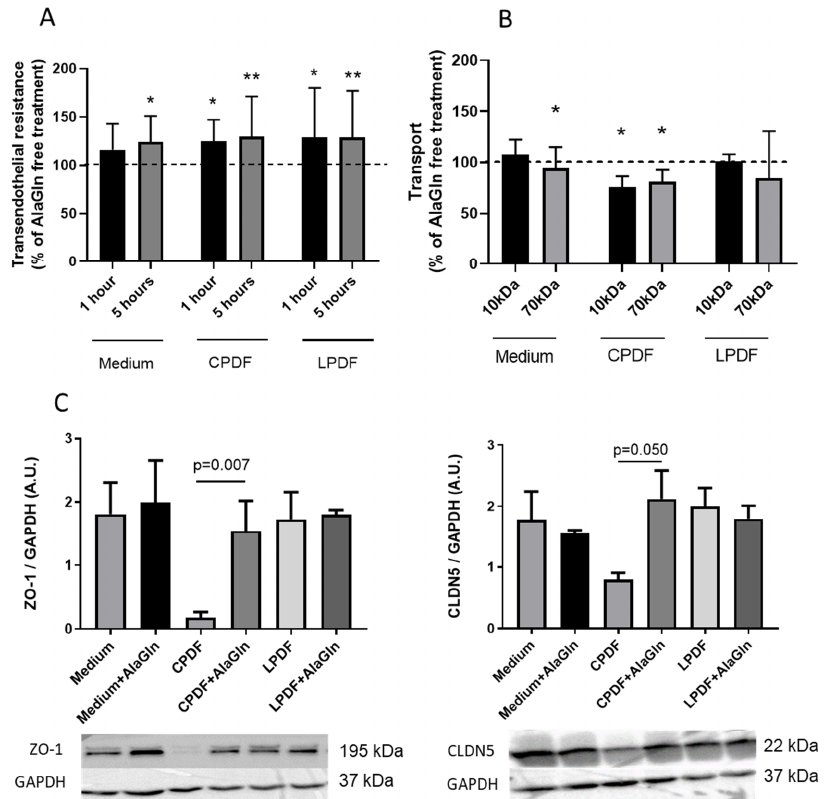
Figure 2. Supplementation of 8 mM alanyl-glutamine (AlaGln) to CPDF and LPDF increased electrical resistance of HUVEC after 1 and 5 h ( A ). 10 kDa and 70 kDa dextran transport was reduced with CPDF only ( B ). Reduction of ZO-1 and CLDN5 protein abundance in CPDF treated HUVEC was